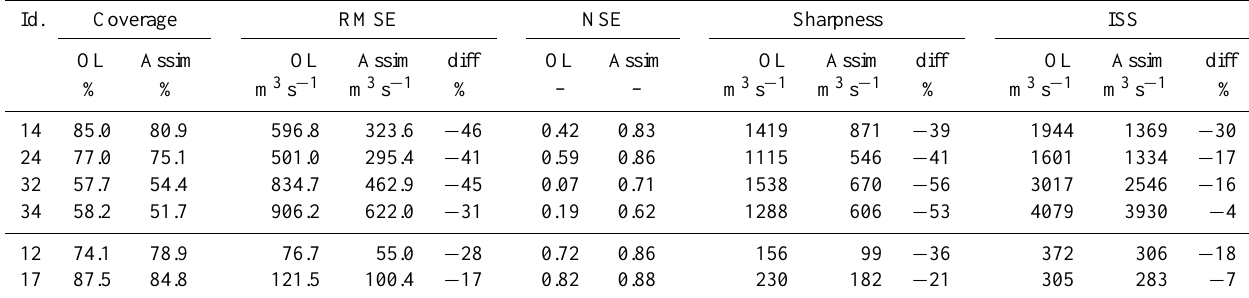
Table 5. OL and Assim results with additional measurement error. Coverage, sharpness and ISS refer to a 0.1 significance level.